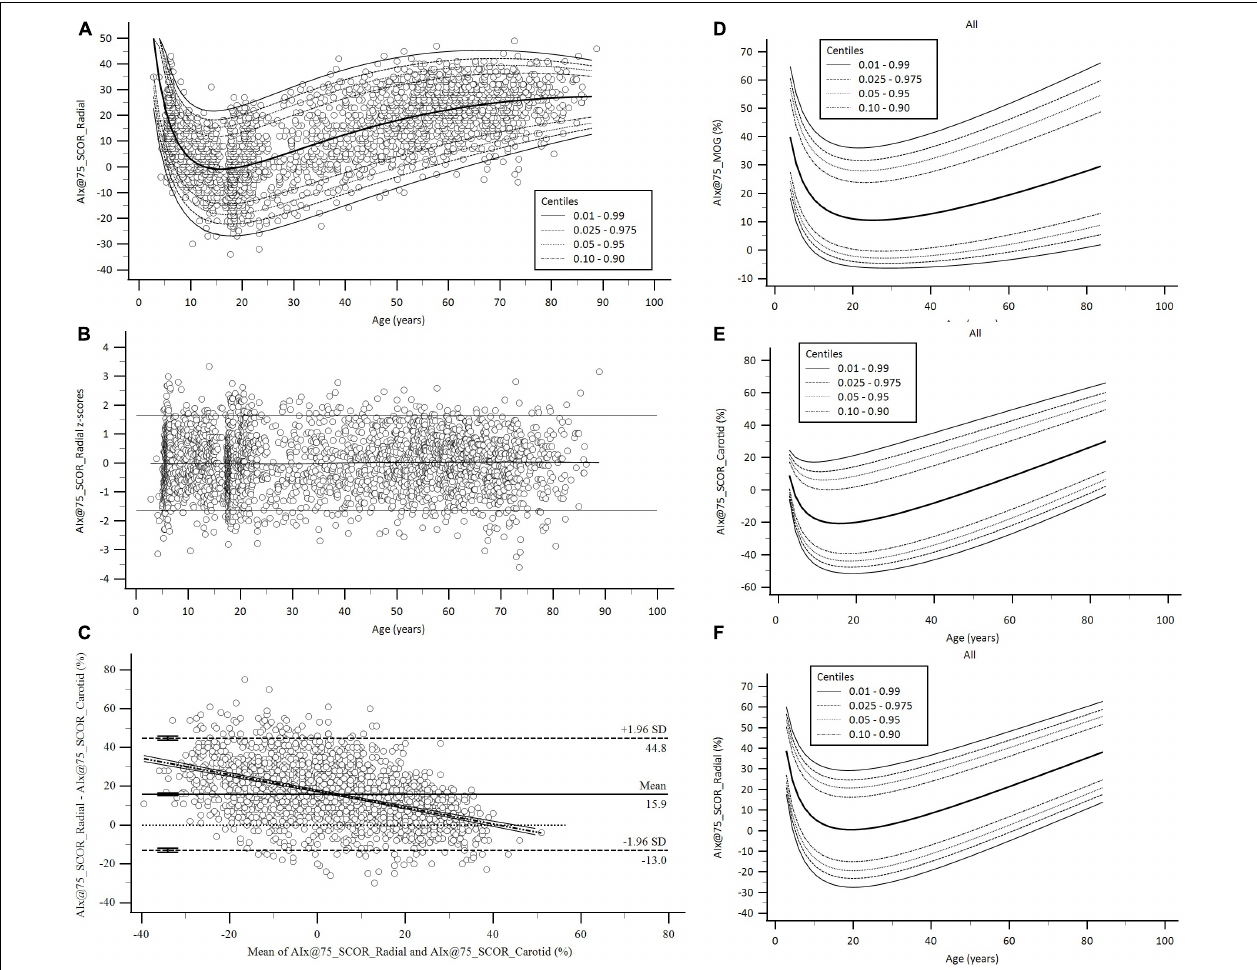
FIGURE 2 | Age-related profiles and Bland–Altman analysis for AIx@75. (A,B) Age-related profiles (1th, 2.5th, 5th, 10th, 50th, 90th, 95th, 97.5th, and 99th percentiles) for AIx@75_SCOR_Radial and z-score diagram used to verify model fit. (C) Bland–Altman diagram for AIx@75_SCOR_Radial and AIx@75_SCOR_Carotid comparison. There were significant mean (15.9, 95% CI.; 15.28 to 16.53%, p < 0.001) and proportional errors (slope coefficient: –0.4234, 95% CI.: –0.4571 to –0.3897, p < 0.001). (D–F) Age-related percentile curves for AIx@75 obtained with three different methods. Age-related percentile curves (1th, 2.5th, 5th, 10th, 50th, 90th, 95th, 97.5th, and 99th percentiles) for AIx@75_MOG, AIx@75_SCOR_Radial, and